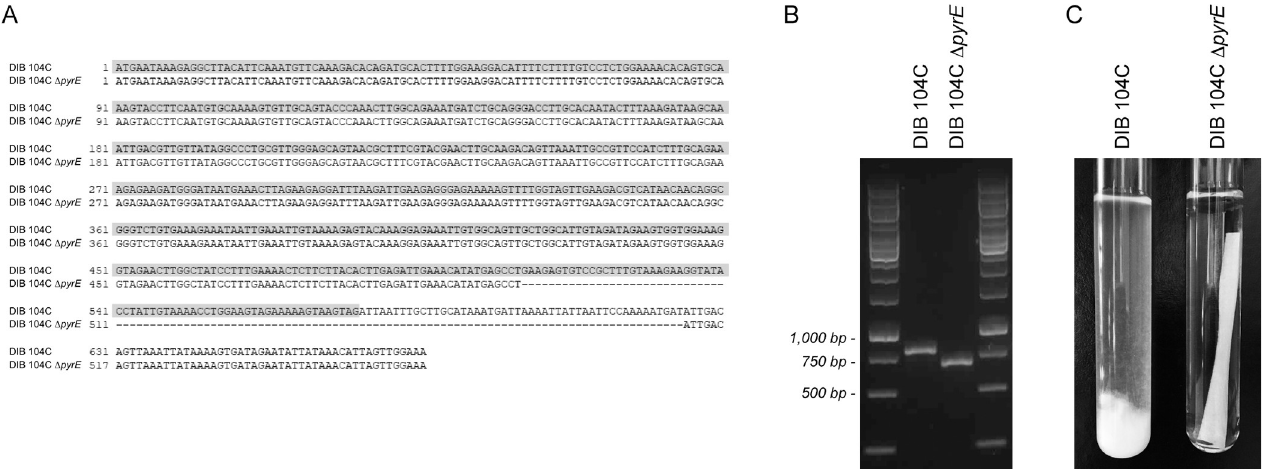
Fig 5. Confirmation of the deletion in the pyrE gene in strain DIB 104C D pyrE . (A) The pyrE open reading frame together with 100 bp immediately downstream of the stop codon was sequenced in strains DIB 104C and DIB 104C D pyrE . The pyrE open reading frame in strain DIB 104C is indicated in grey. (B) The pyrE gene was PCR amplified from genomic DNA of strains DIB 104C and DIB 104C D pyrE using primers BLU13/14 (S1 Table), which bind upstream and downstream of the pyrE open reading frame. (C) The uracil auxotrophy of strain DIB 104C D pyrE was checked by incubating cells in MOPS-buffered medium with filter paper and CSM-Ura. Incubation was performed at 70˚C for 4